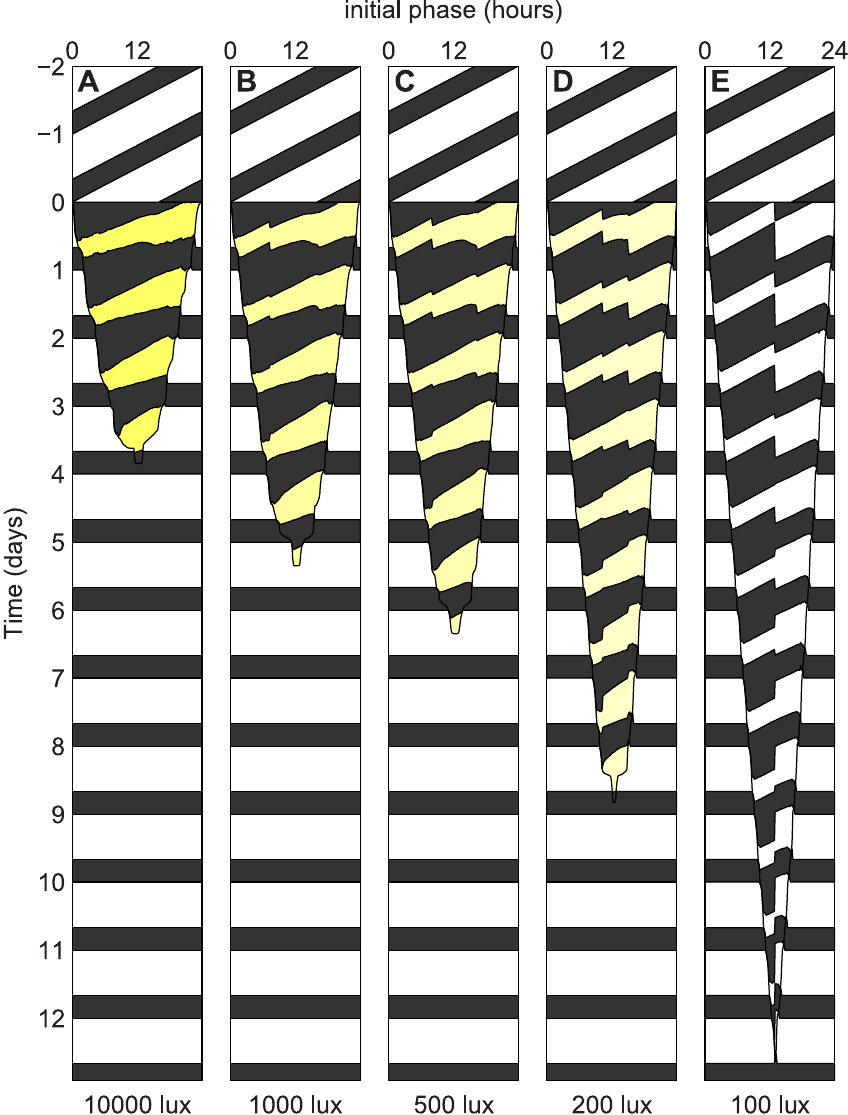
Figure 4. Optimal schedules for all phase shifts. This plot shows the pattern of bright light (200 lux–10,000 lux, yellow), background light (100 lux, white), and darkness (0 lux, black) under which the clock is optimally reset from the corresponding initial phase. If a vertical line is drawn on the plot, then the pattern of light and dark along this vertical line is the optimal schedule for resetting the clock from the corresponding initial phase. Figure ( A ) shows the optimal schedules for resetting the clock when 10,000 lux light is available; ( B ) 1000 lux; ( C ) 500 lux; ( D ) 200 lux; ( E ) 100 lux.